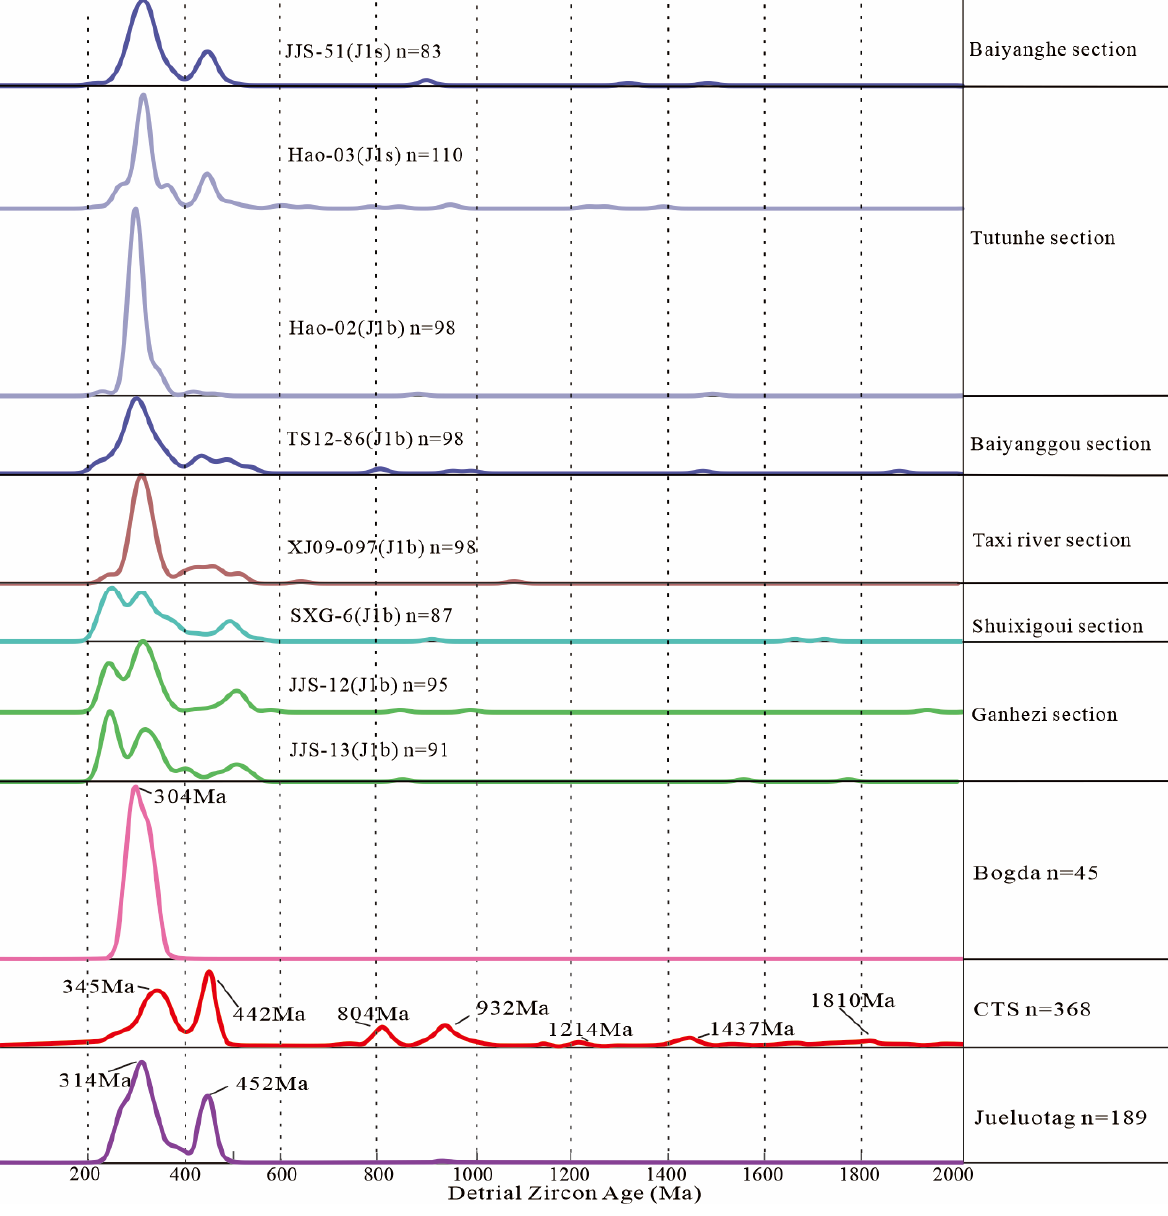
Figure 6. KS P-values tests for Early Jurassic samples (same derived data as those in Figure 5; 95% confidence that the two groups were not statistically different; p -values had to exceed 0.05; compar- isons between units with p -values greater than 0.05 are highlighted in yellow).